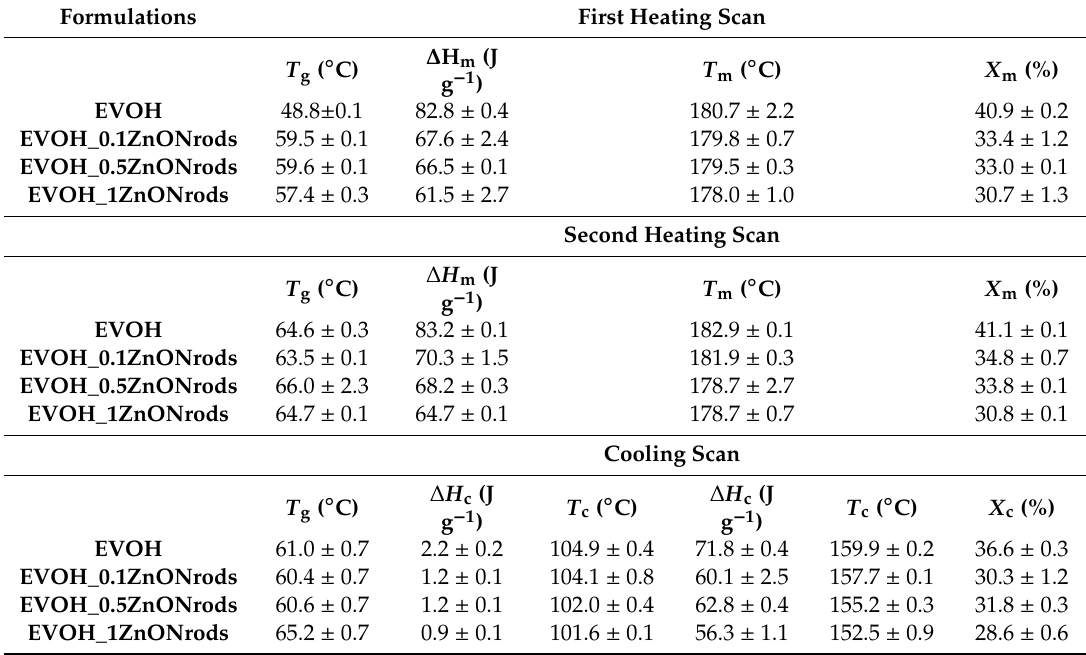
Table 2. Di ff erential scanning calorimetry (DSC) data of EVOH base systems.